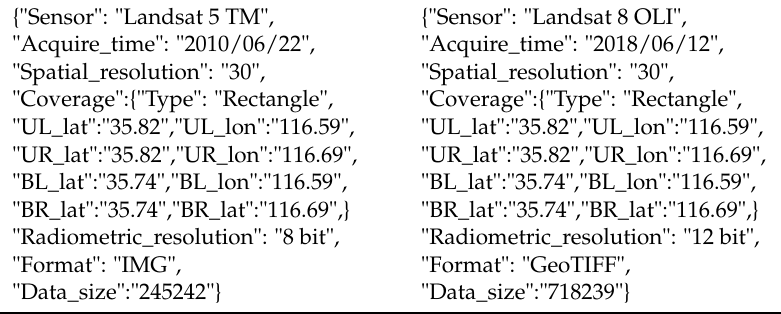
Table 4. JavaScript object notation (JSON) description of input1 image (left) and input2 image (right).